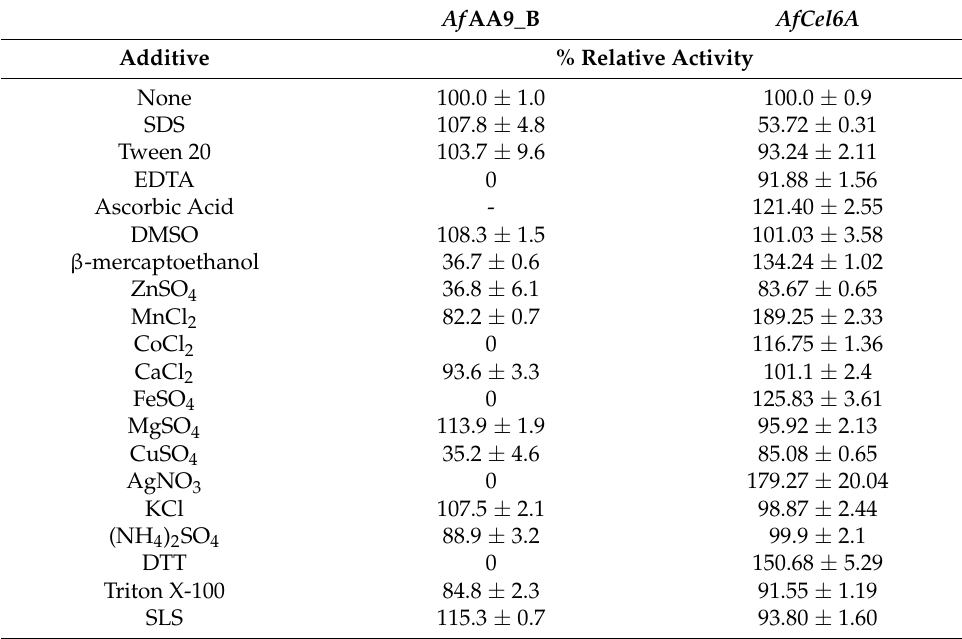
Table 4. Effects of additives on Af Cel6A and Af AA9_B